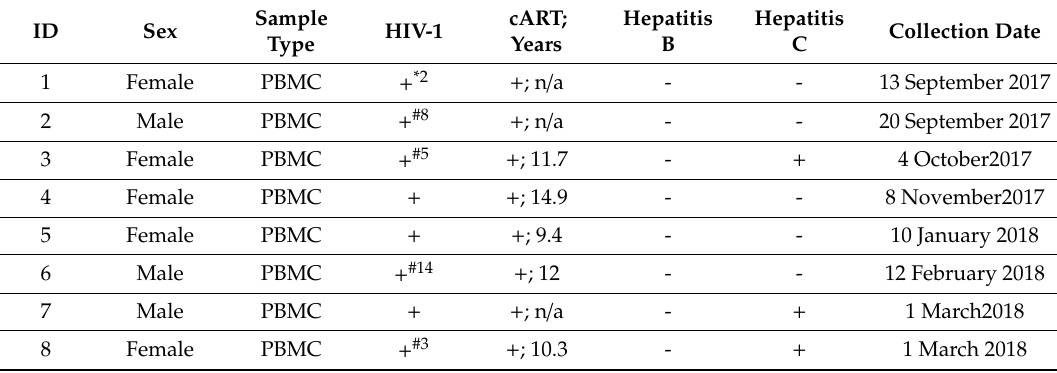
Table 1. Human cohort